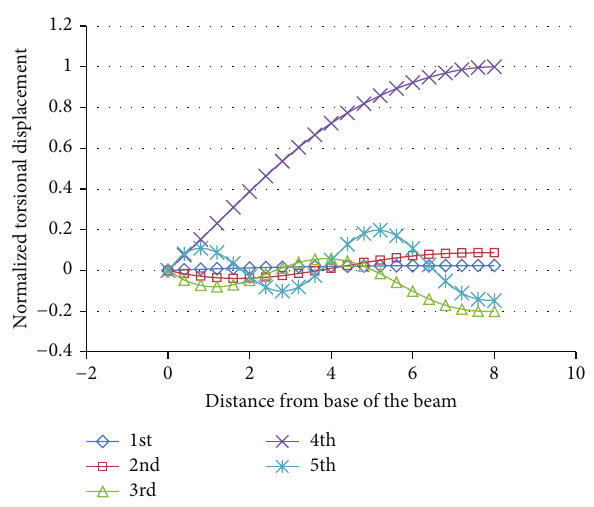
Figure 12: DSM torsion mode